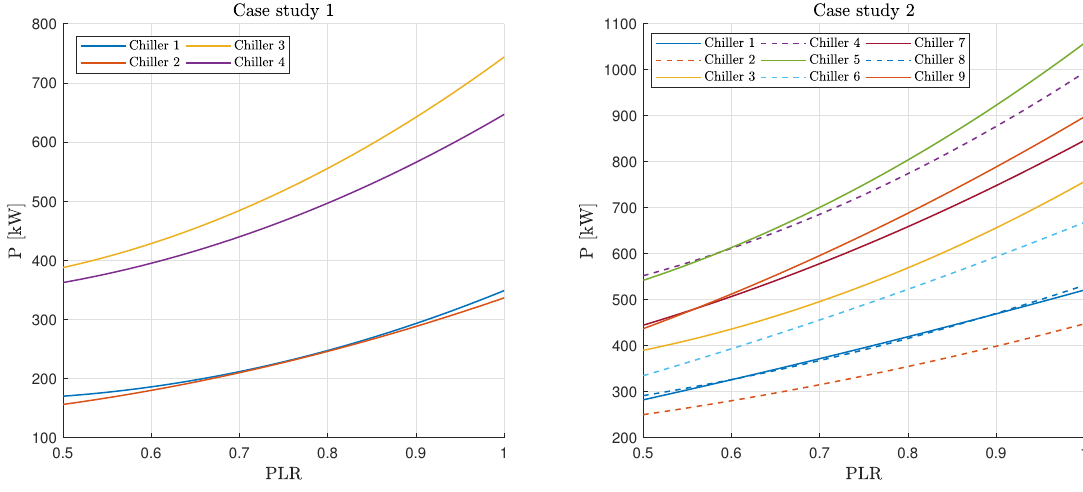
Figure 2. Estimated chillers’ P-PLR curves on case study 1 ( left ) and case study 2 ( right